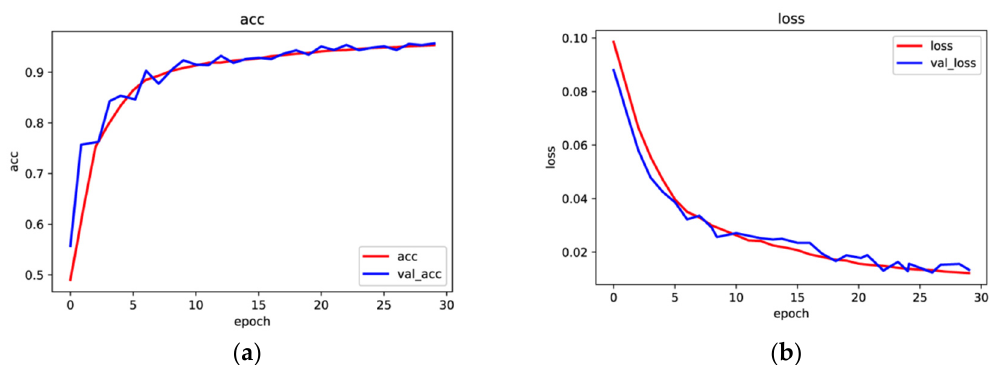
Figure 11. ( a ) The training and validation accuracy both will increase with epochs, whereas ( b ) the training and validation loss decreases with epochs.